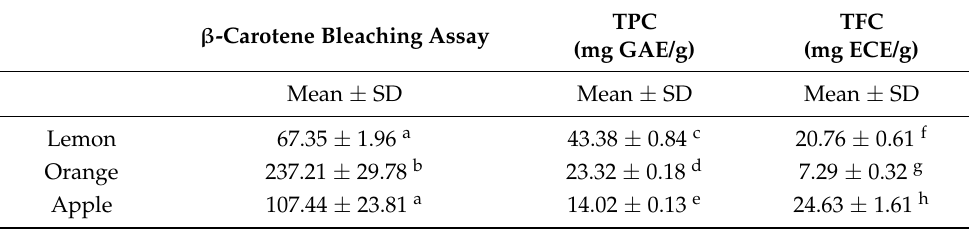
Table 2. Antioxidant capacity and characterization of different fruit by-products. The results are expressed as Mean ± SD. Different letters indicate statistical